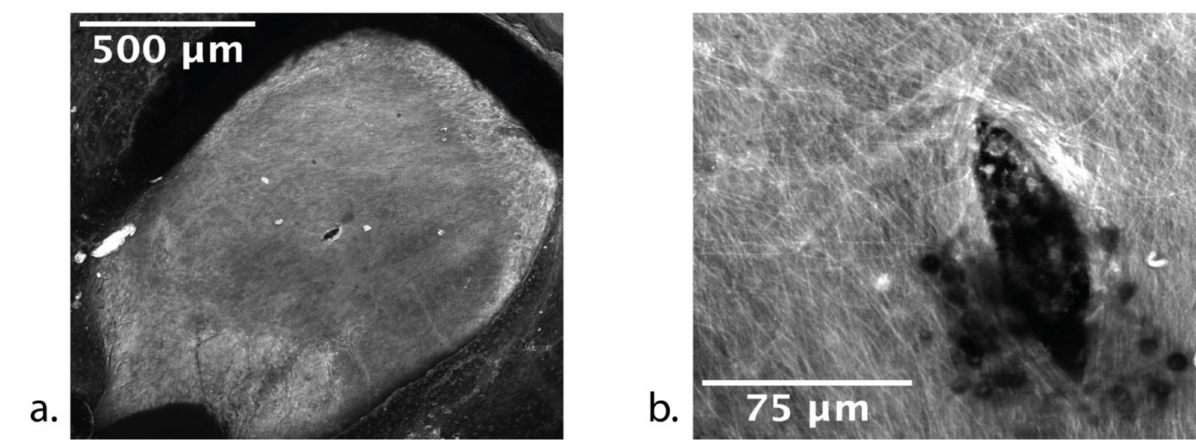
Figure 3. Confocal image of a guinea pig RWM around a perforation with ( a ) low magnification and ( b ) high magnification showing connective fibers of the membrane. (Reprinted with permission from Ref. [35], 2018, Jeffrey W. Kysar, PhD and Anil K. Lalwani,